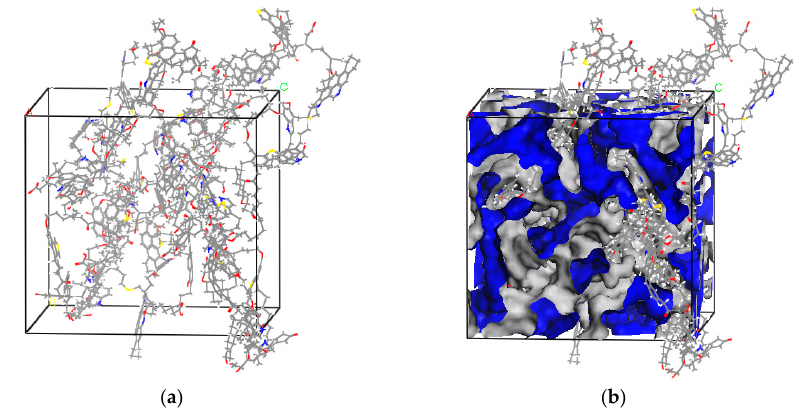
Figure 2. Kerogen model: ( a ) 3D model and ( b ) pore size distribution.